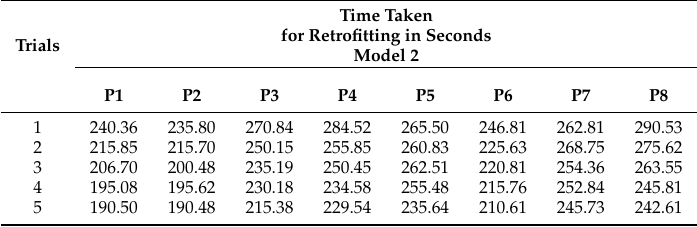
Table 5. Task 3: Control group participant’s time taken for retrofitting Model 2.